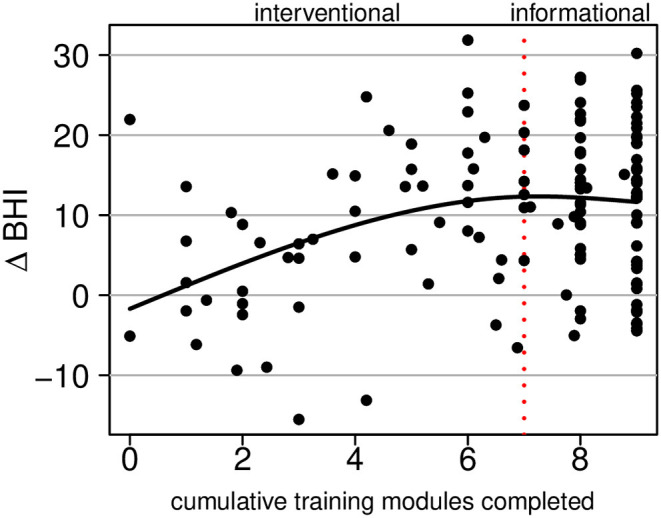
Regression of the change in the BrainHealth Index on the number of cumulative training modules completed by the participant. The first seven modules constitute interventional training; the remaining two are informational only.